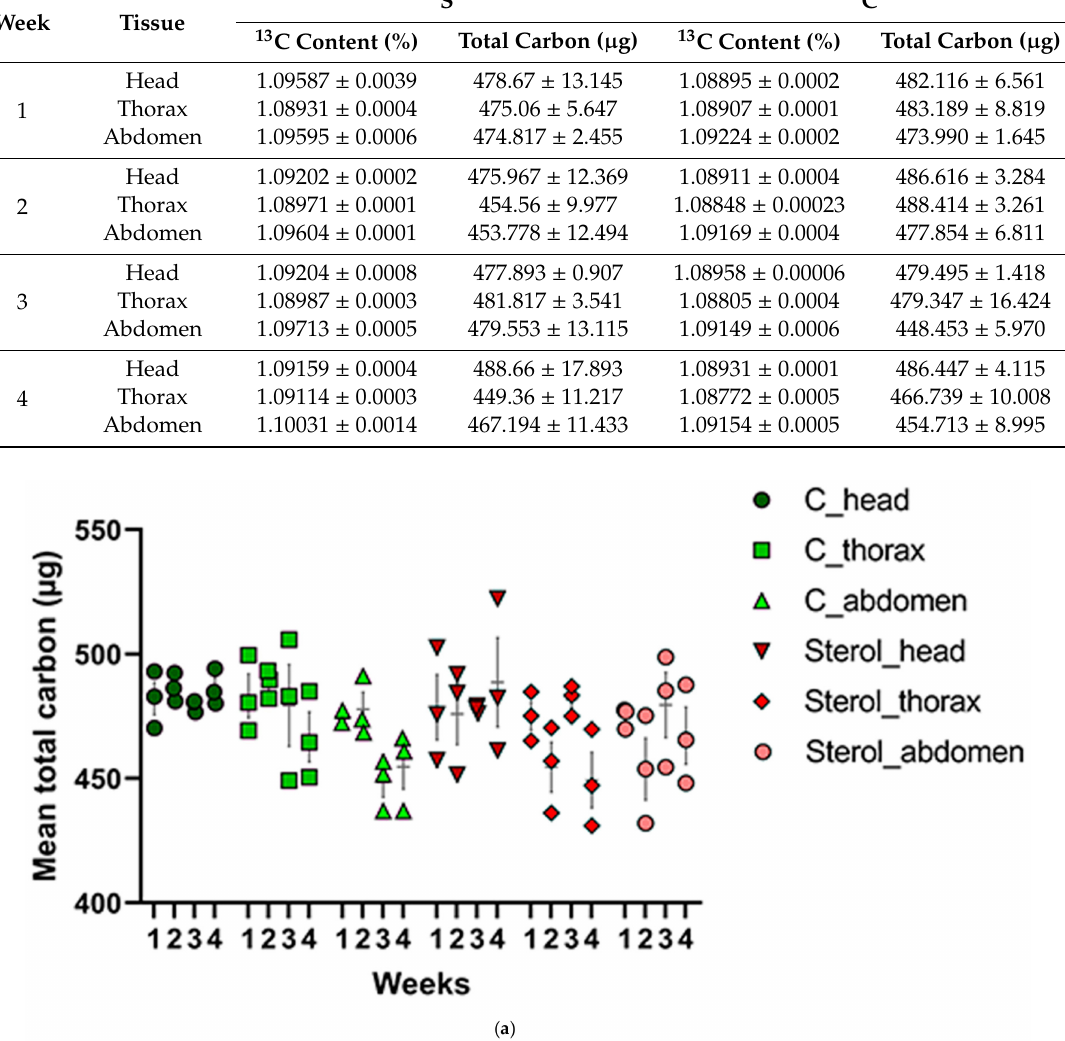
Table 1. Mean values ± SEM for % 13 C and total carbon, across all bee tissue types over the four weeks of the experiment, where honey bees in the control group (C) were fed a control diet (no sterol); honey bees in the labeled 24-methylenecholesterol supplemented group (S) were fed a diet containing 0.25% 13 C-labeled 24-methylenecholesterol.